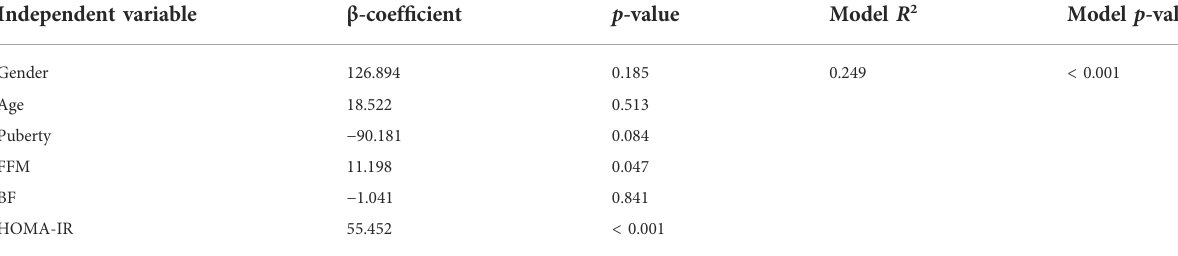
TABLE 3 Multiple linear regression analysis of resting energy expenditure.